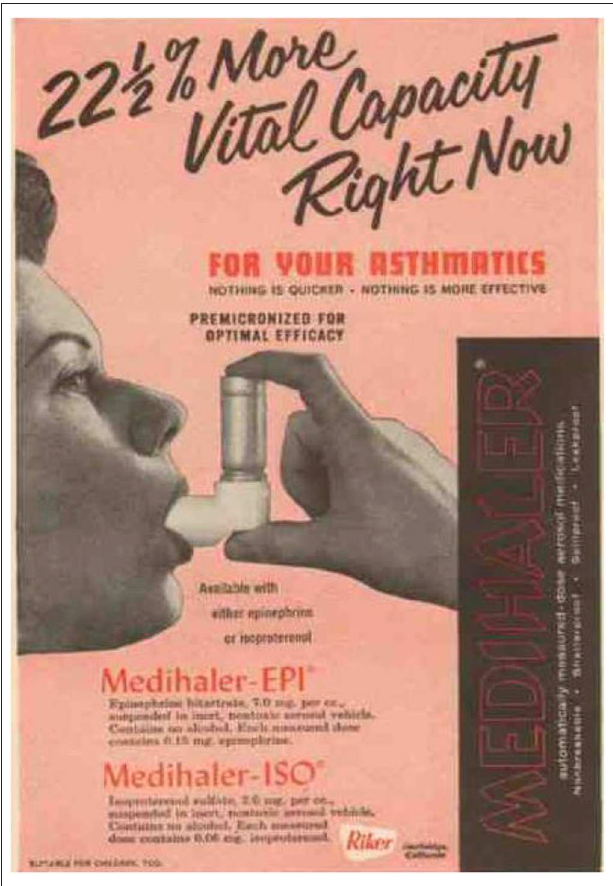
FIGURE 1 | Advert for Medihaler (1956) http://museum.aarc.org/gallery/